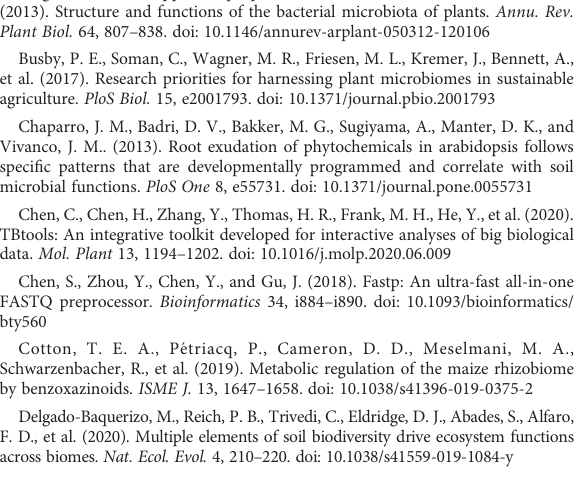
SUPPLEMENTARY FIGURE 1 Species accumulation curve of bacteria. SUPPLEMENTARY FIGURE 2 OPLS-DA for the comparison of metabolomic pro fi les between M and G. SUPPLEMENTARY FIGURE 3 Correlation between the differential secondary metabolites and differential microbial taxa in rhizosphere of A. sinensis. (*, P <=0.05; **, P <= 0.01; ***, P <=0.001.). SUPPLEMENTARY FIGURE 4 Correlation between the medicinal components and differential microbial taxa in rhizosphere of A. sinensis. (*, P <=0.05; **, P <= 0.01; ***, P